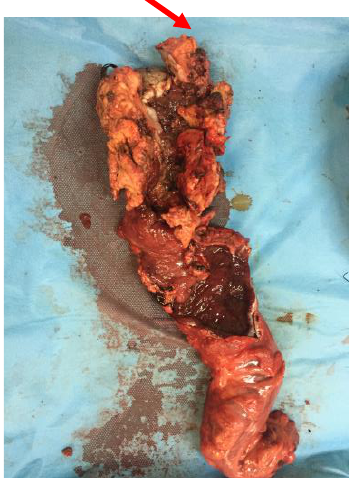
Figure 9. Specimen of abdominoperineal resection showing malignant transformation after local recurrence.